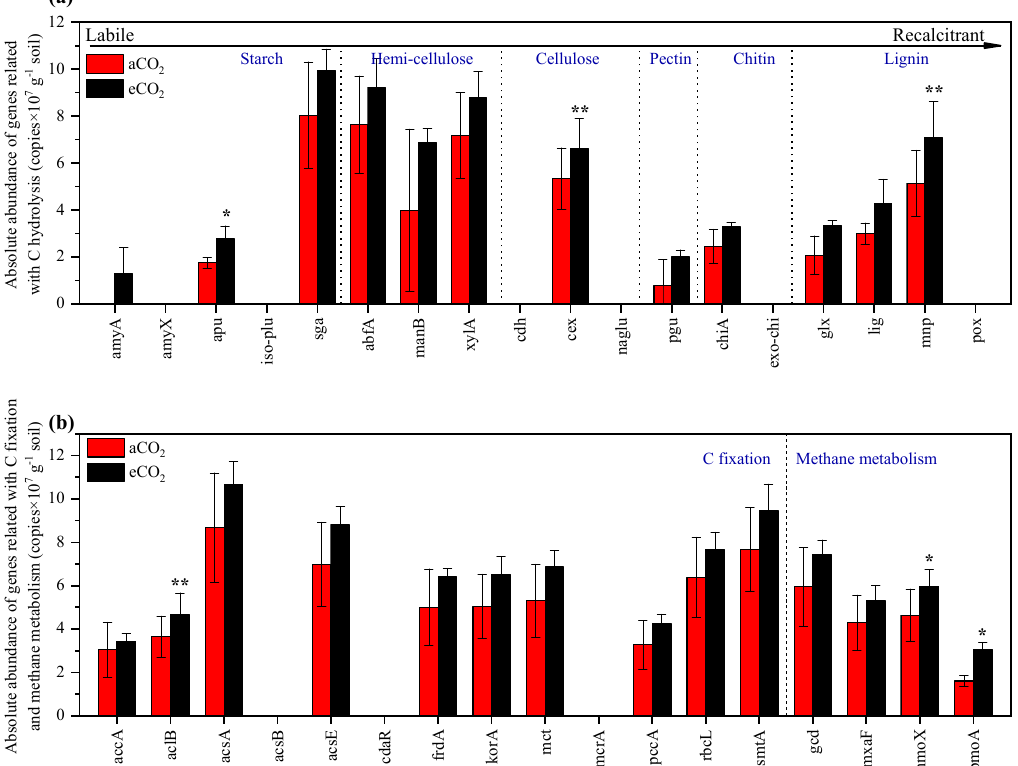
Figure 4. ( a ) Absolute abundance of genes related with C hydrolysis under aCO 2 and eCO 2 . ( b ) Absolute abundance of genes related with CO 2 fixation and methane cycling under aCO 2 and eCO 2 . The genes are arranged by the biodegradability of their target substrates, from labile to recalcitrant. p < 0.05, *; p < 0.01, **.